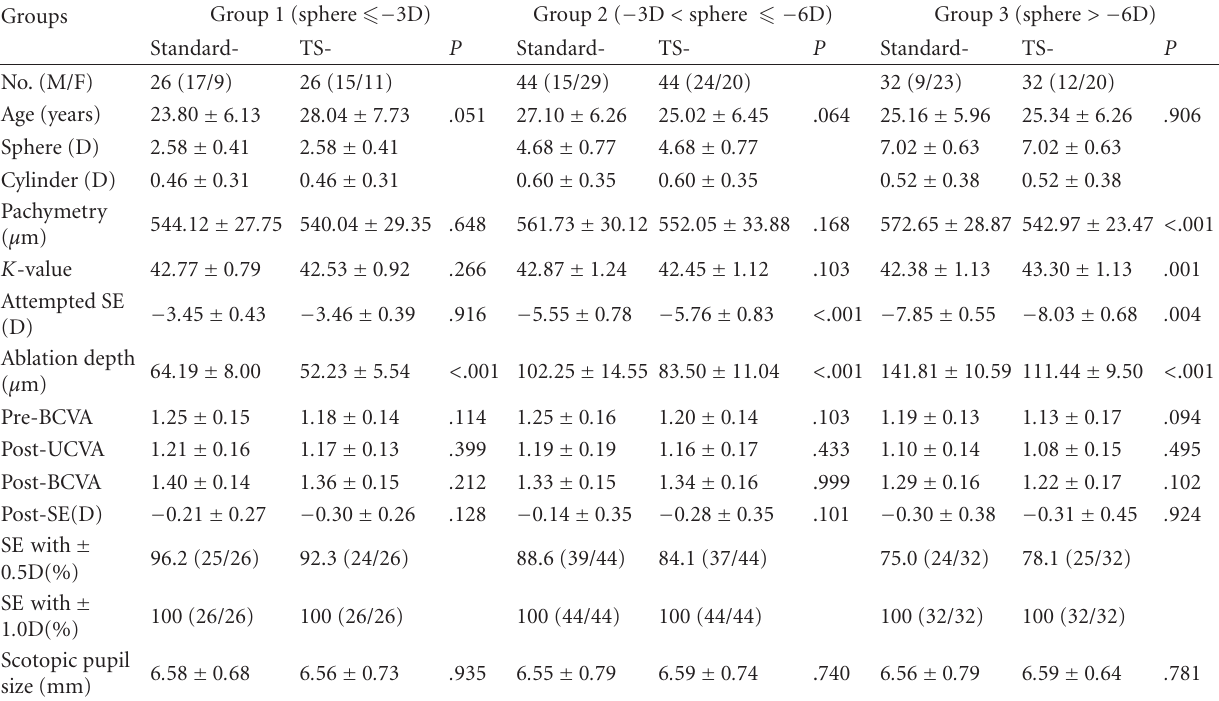
Table 1: Baseline characteristics of 102 matched eyes that underwent tissue-saving LASIK or standard LASIK treatment for myopia.